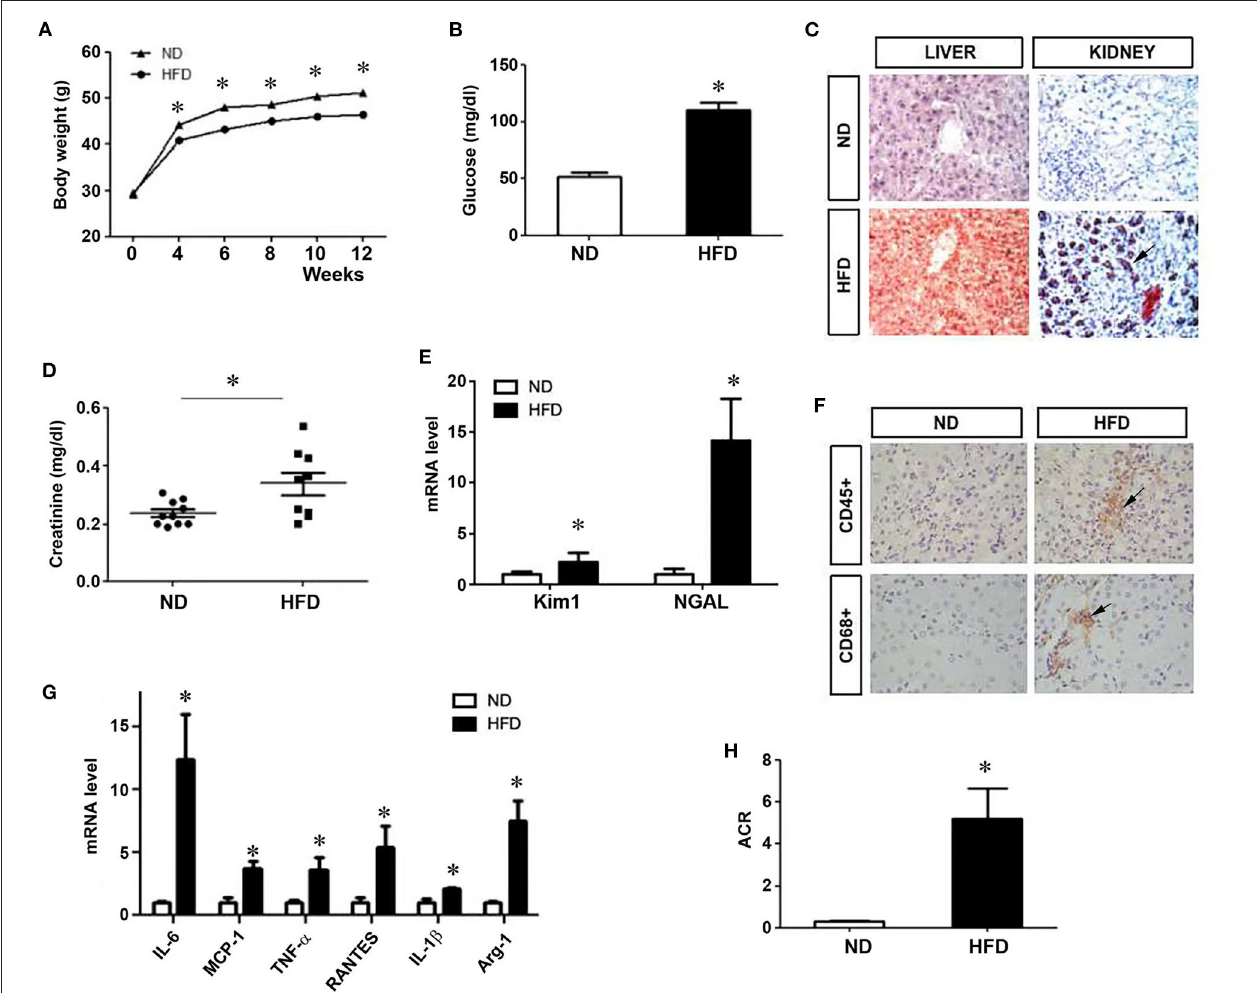
FIGURE 1 | Kidney injury in mice on a high-fat diet. After mice were given a high-fat diet for 12 weeks, body weight (A) and blood glucose (B) were measured. (C) Liver and kidney tissues were subjected to oil red staining for lipid deposition. (D) Serum creatinine levels were measured. Renal expression of Kim1 and NGAL mRNA was assessed (E) . (F) Immunohistochemical staining for CD45 + and CD68 + cells in kidney tissues. (G) Quantitative real-time RT-PCR shows the relative abundances of proinflammatory cytokines as indicated. (H) Urinary albuminuria levels in different groups. Albumin to creatinine ratio (ACR) was presented. ND, Normal diet; HFD, high fat diet; * P < 0.05, ND vs. HFD, n =